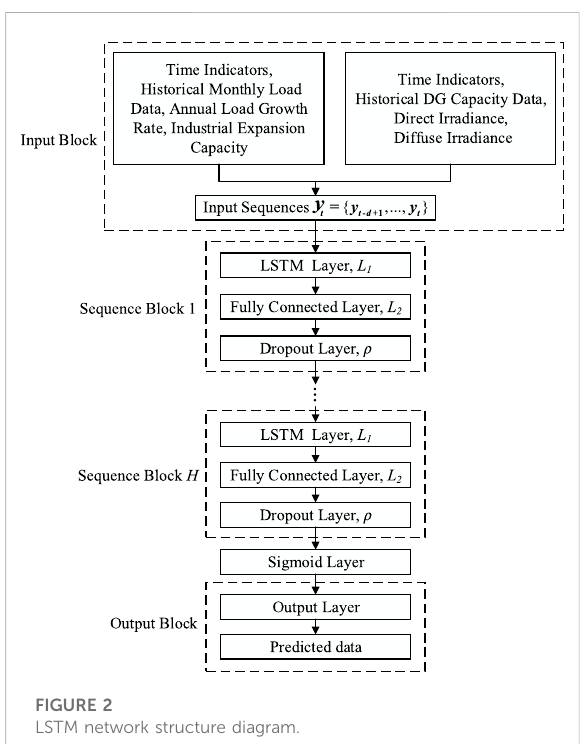
FIGURE 2 LSTM network structure